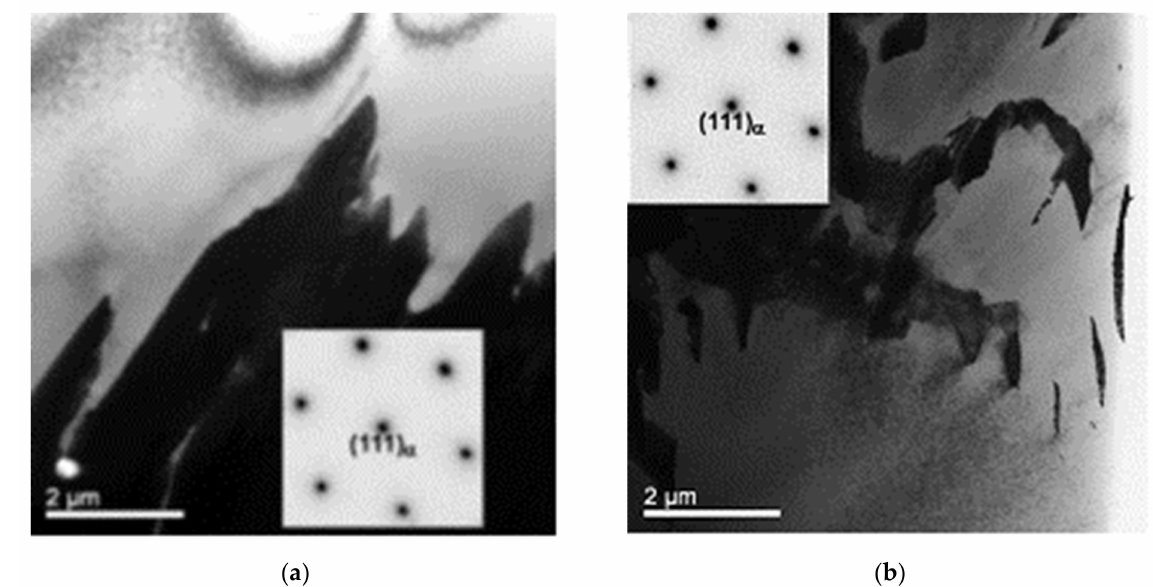
Figure 29. ( a , b ) are two examples of alpha-prime martensite formed at the fracture surface following IASCC testing of a 30 dpa Type 304 austentic stainless steel